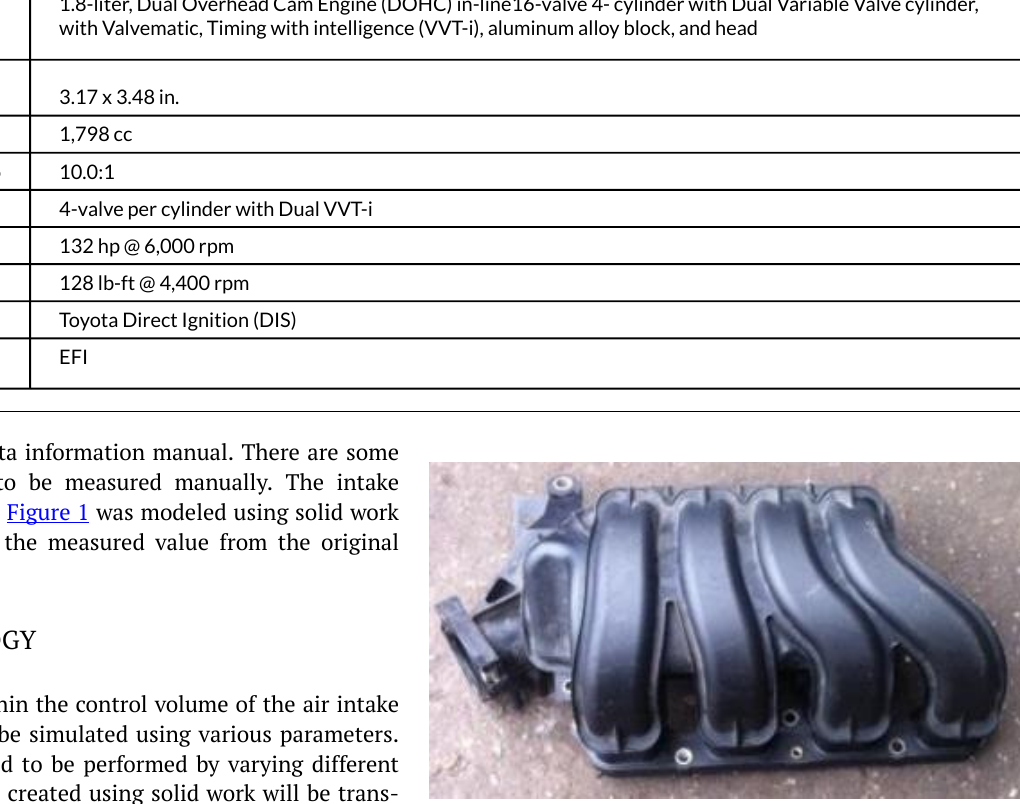
Fig. 1. Air intake manifold (Toyota Corolla